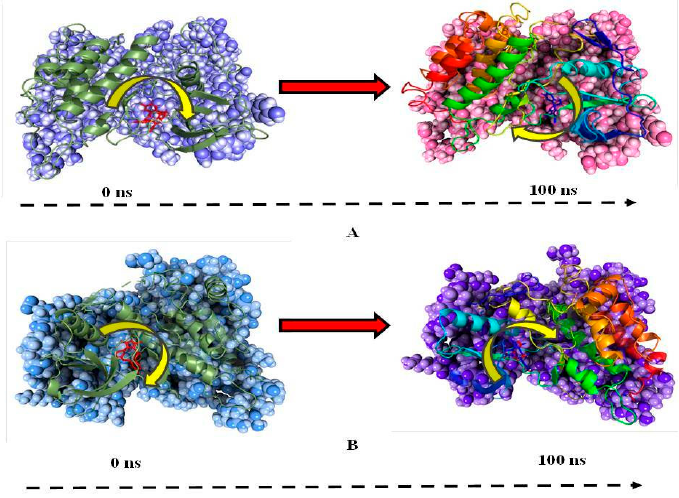
Figure 17. MMGBSA trajectory (0 ns, before simulation and 100 ns, after simulation) exhibited conformational changes upon binding the ligands with the protein, ( A ) ALK-172; ( B ) ALK-178. The arrows indicating the overall positional variation (movement and pose) of 172 and 178 at the binding site cavity. Table 4. Binding energy calculation of 172 and178 with ALK and non-bonded interaction energies from MMGBSA trajectories. (* indicates mean value of energy parameters)